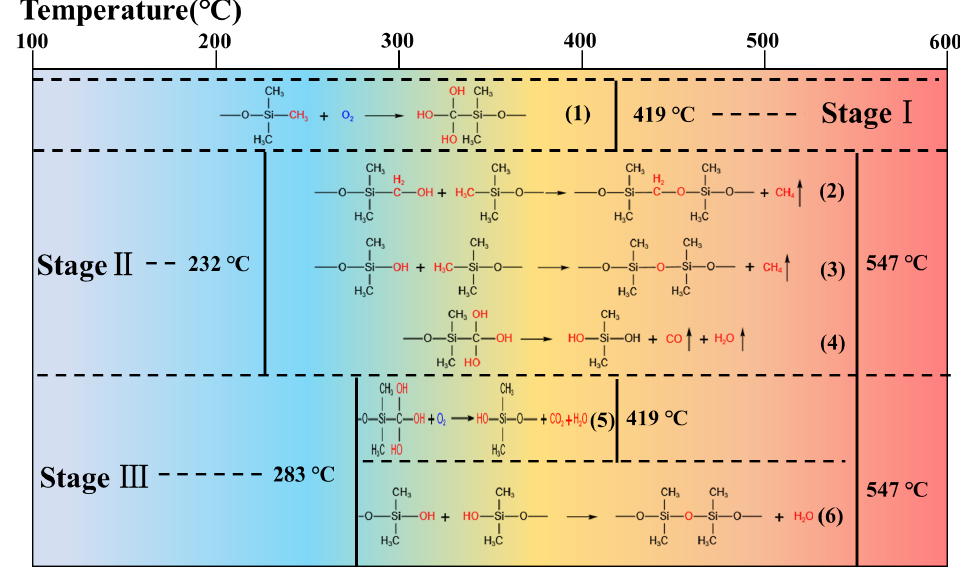
Figure 7. The chemical pyrolysis process of silica aerogel.